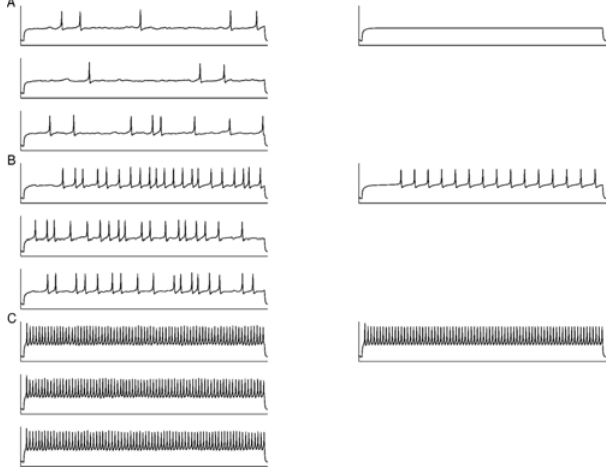
be seen from Figure 6, the deterministic model (right panels) does